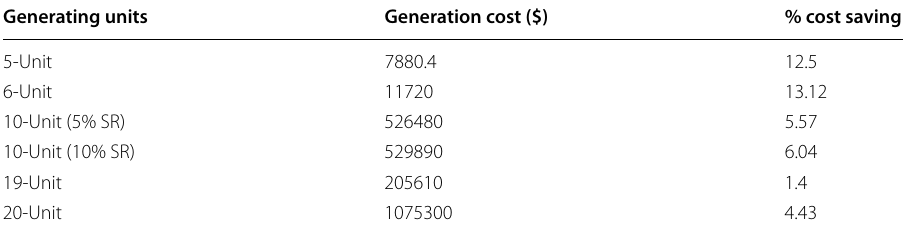
Table 25 Overall cost for generation of each unit with renewable energy sources in Autumn &